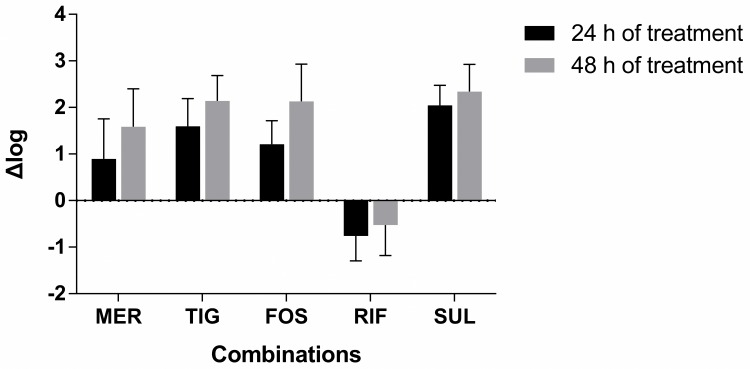
Comparison of the efficacies of colistin-fusidic acid combination vs other combinations after 24 and 48 h of treatment.CST, colistin; MER, meropenem; TIG, tigecycline; FOS, fosfomycin; FD, fusidic acid; RIF, rifampin; SUL, sulbactam. Δlog means the log10 recovered CFU of other combinations minus the log10 recovered CFU of colistin-fusidic acid combination.